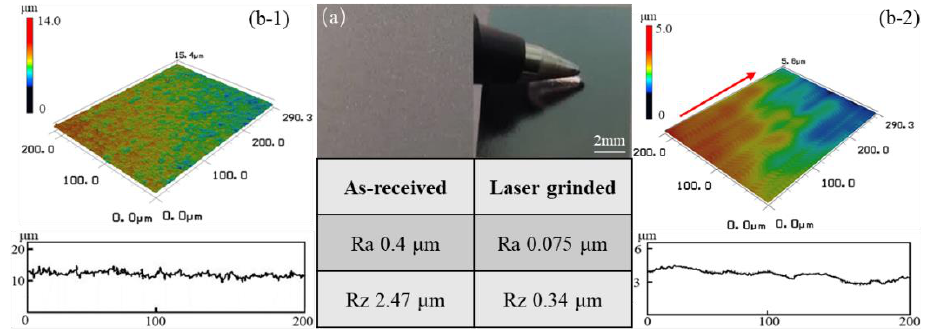
Figure 2. Surface topography: ( a ) as-received and laser-grinded surfaces at macro-scale; ( b-1 ) 3D topographic image of as-received surface, ( b-2 ) 3D topographic image of the laser-grinded surface.